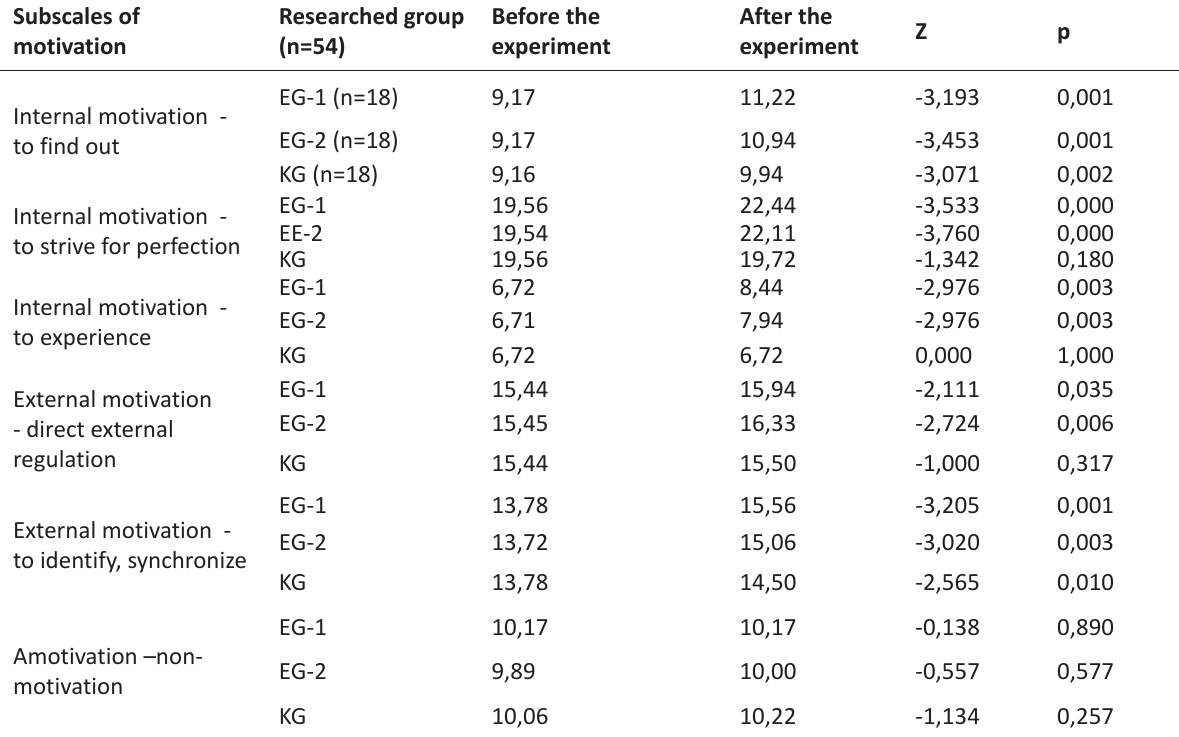
Table 1. Mean evaluation of alternation of the subscales of motivation in juvenile (9–11 years old) sports dancers during the 12-week period of the experiment in points (n=54).